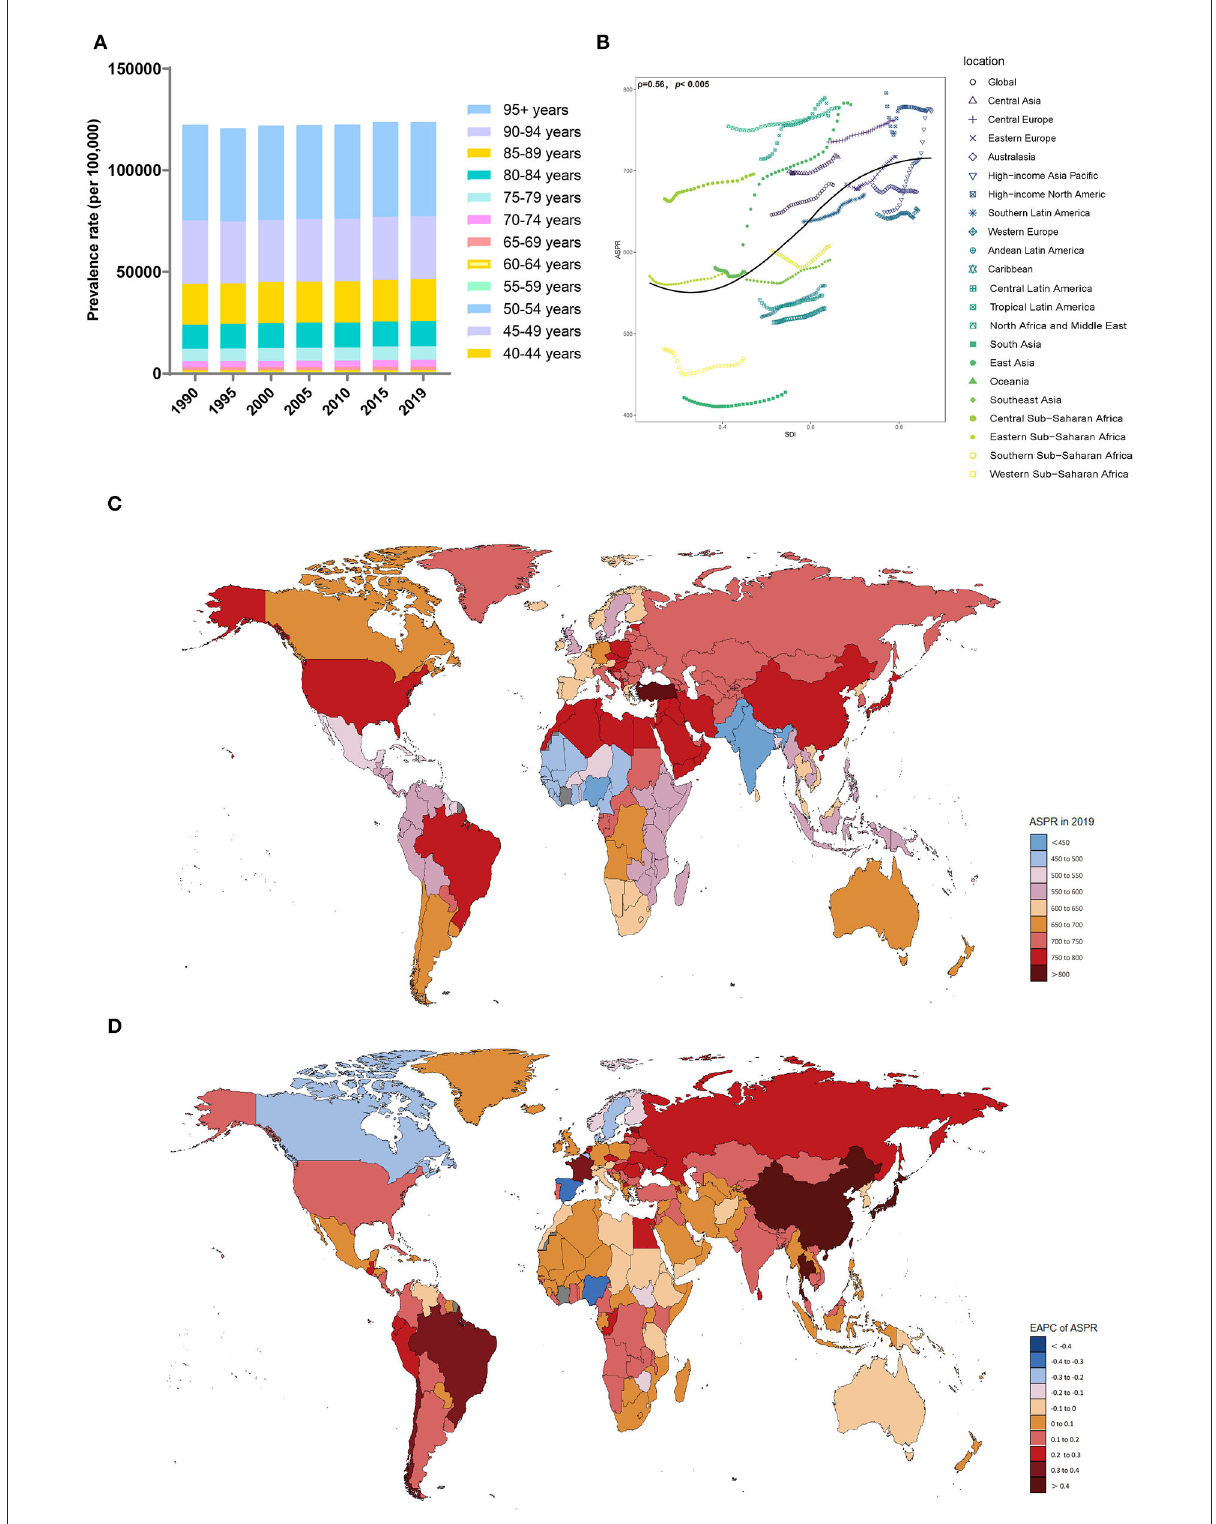
FIGURE2 Distribution of the prevalence of Alzheimer’s disease and other dementias in 204 countries and territories from 1990 to 2019 by age group and SDI region. (A) Prevalence rate in each age group; (B) Correlations between the ASPRs of Alzheimer’s disease and other dementias and SDI regions in 2019; associations were calculated with Pearson correlation analysis; (C) The ASPRs in 204 countries and territories; (D) EAPCs in the ASPRs in 204 countries and territories. SDI, sociodemographic index; ASPR, age-standardized prevalence rate; EAPC, estimated annual percent